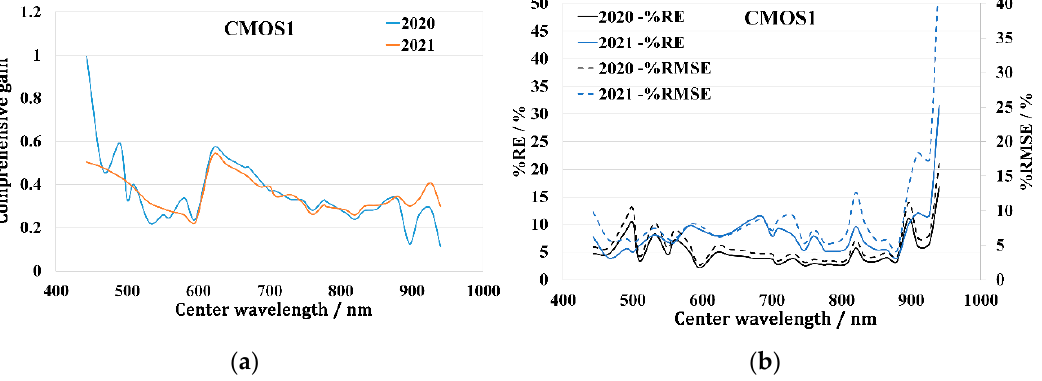
Figure 13. Comprehensive gain fitting results and fitting errors of OHS-F CMOS1. ( a ) Description of comprehensive gain fitting results; ( b ) description of comprehensive gain fitting error.